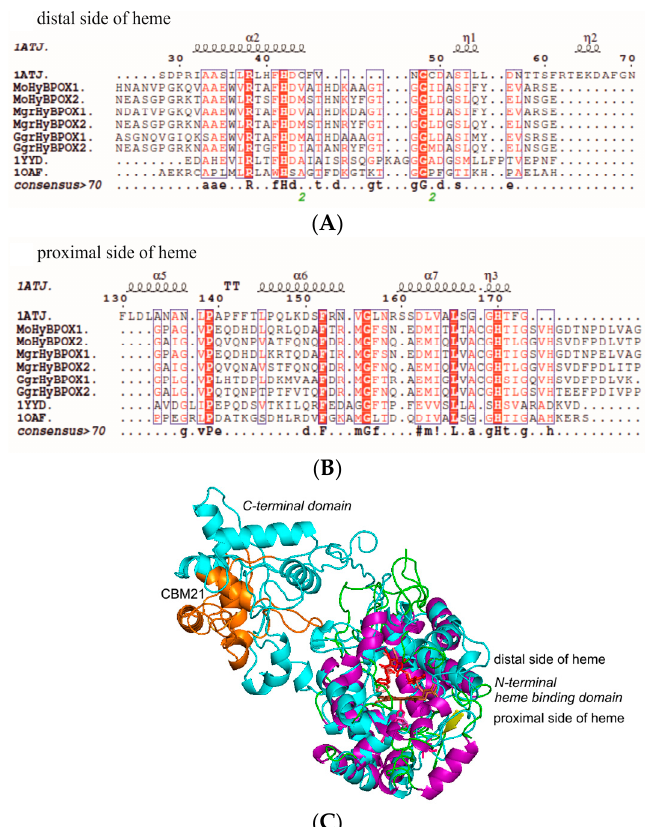
Figure 6. Peculiar conserved domain architecture of hybrid B heme peroxidases. Multiple structural alignment of selected HyBPOX protein sequences against the closest known experimental structure of a Family III representative (1ATJ coding for horseradish peroxidase). Regions shown: ( A ) on the distal side of prosthetic heme group and ( B ) on the proximal side of the prosthetic heme group. For comparison, also corresponding sequence regions of Family II manganese peroxidase (1YYD from Phanerochaete chrysosporium ) and Family I ascorbate peroxidase (1OAF from Glycine max ) are included. Performed with ESPript 3.0 [36]. Secondary structure elements from the structure of 1ATJ are indicated above the alignment. ( C ) Homology model of protein domains for MoHyBPOX1 from Magnaporthe oryzae performed with I-Tasser [35] in structural overlay with the template 1ATJ (horseradish peroxidase). This model was rendered with